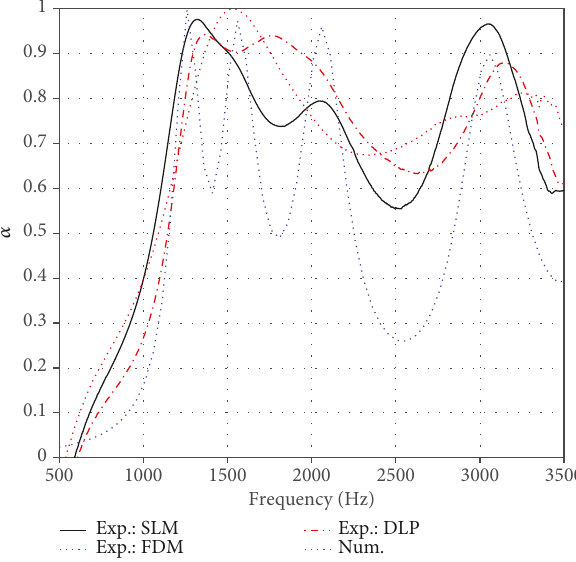
Figure 11: Absorption coe ffi cient for combined 4-, 6-, 8-, and 10- layer depths of the DENORMS